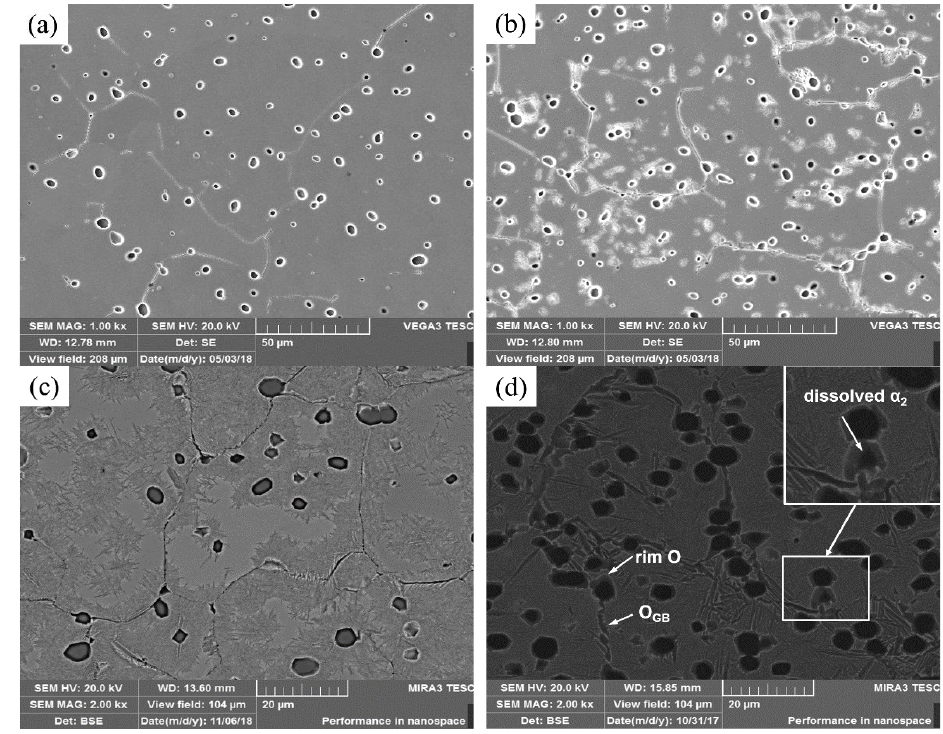
Figure 5. Scanning electron micrographs of Ti-22Al-25Nb alloy cooled at different rates from 1020 °C: ( a ) 4 °C/s, ( b ) 1 °C/s, ( c ) 0.4 °C/s, ( d ) 0.1 °C/s.